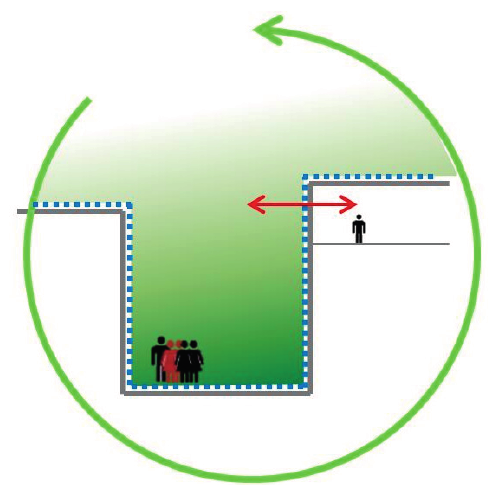
Figure 4. The positive